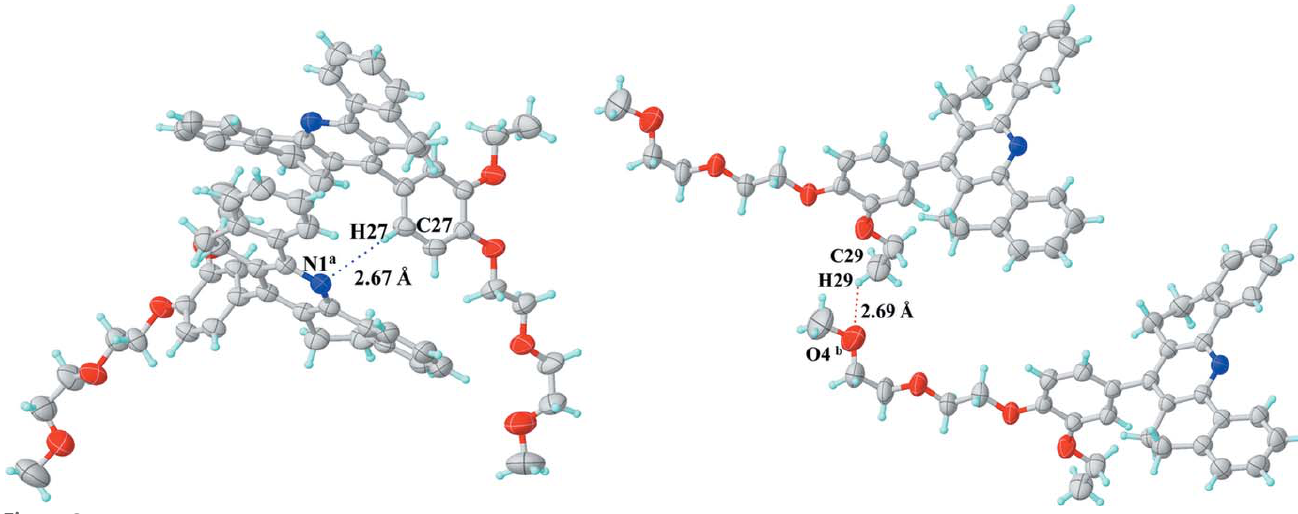
(cid:5) y , z (cid:5) 1 ; ( b ) x , y , z (cid:5) 1. 2 2